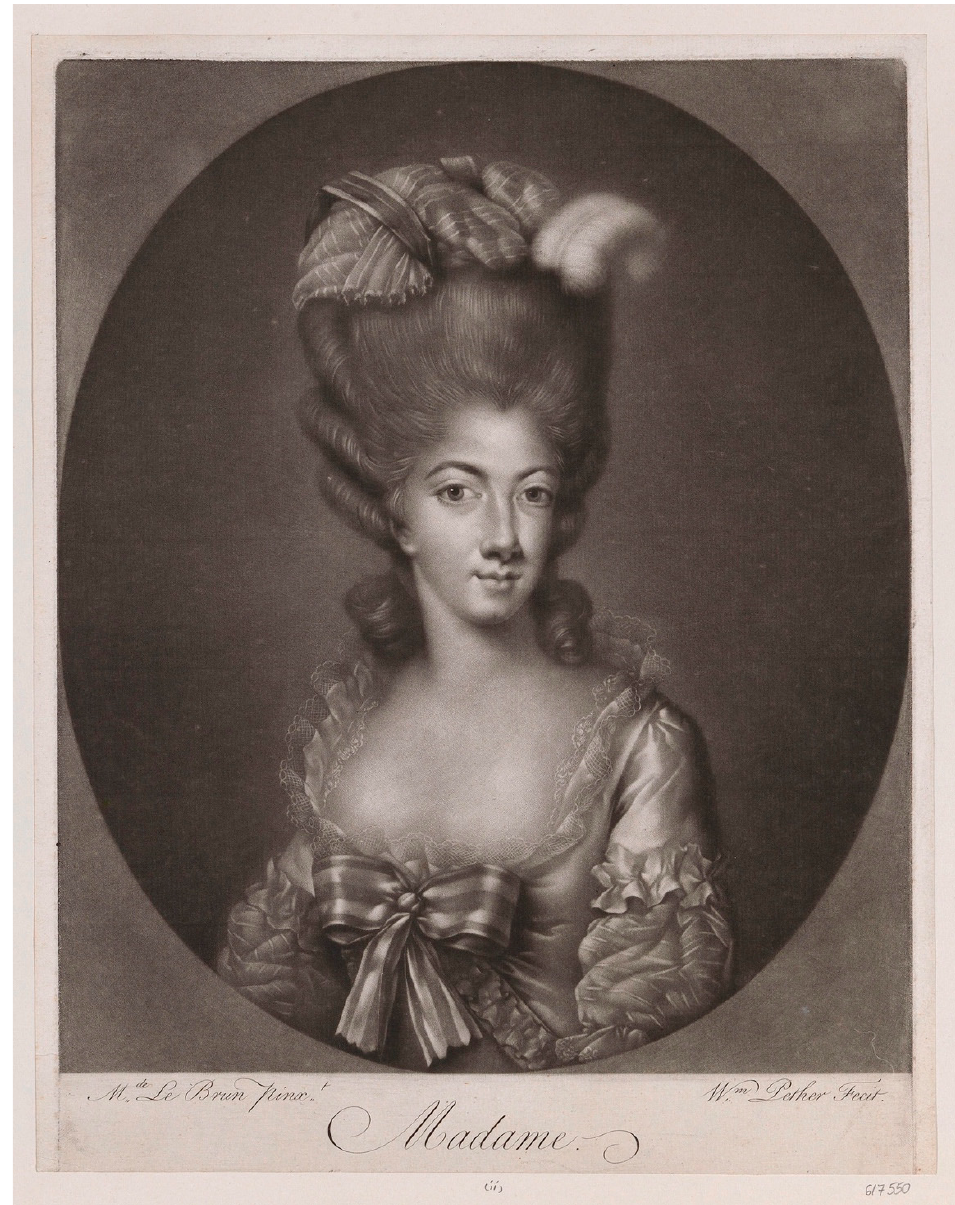
Figure 2. William Pether, Madame , 1778, mezzotint, 349 × 278 mm. Royal Collection Trust, London. Credit line: Digitized by Royal Collection Trust/© Her Majesty Queen Elizabeth II 2022.